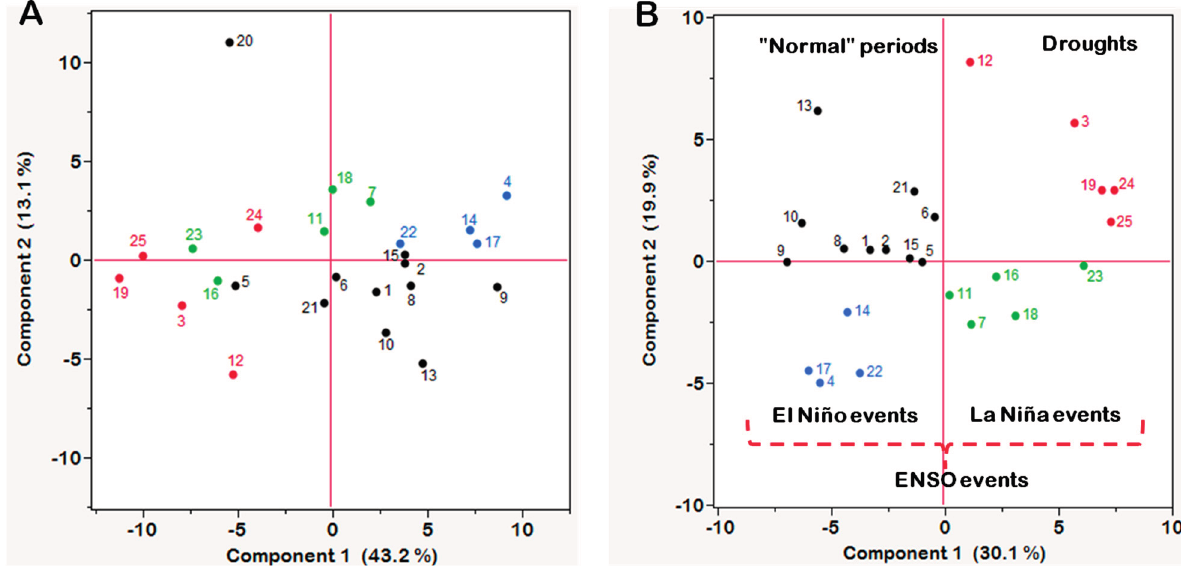
Figure 2. Score plots of ( A ) untransformed (raw) NDVI data, ( B ) centered log-ratio (clr) transformed NDVI data. The numbers represent years chronologically starting from 1982 (1) to 2006 (25). Similar color scheme represent like events/phenomenon that occurred in the particular